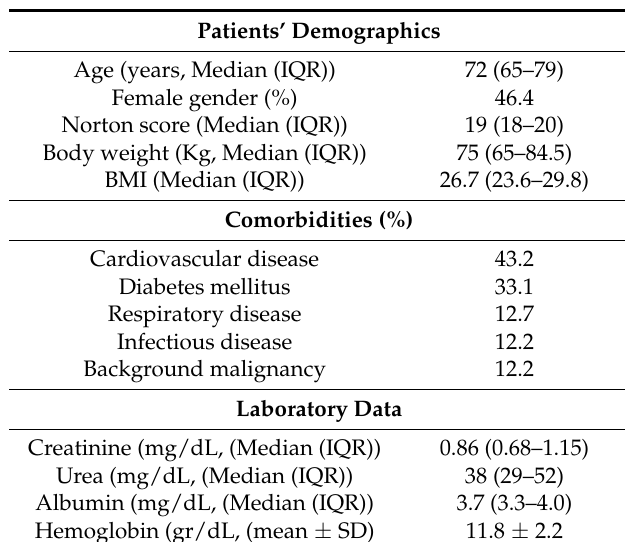
Table 1. Patients’